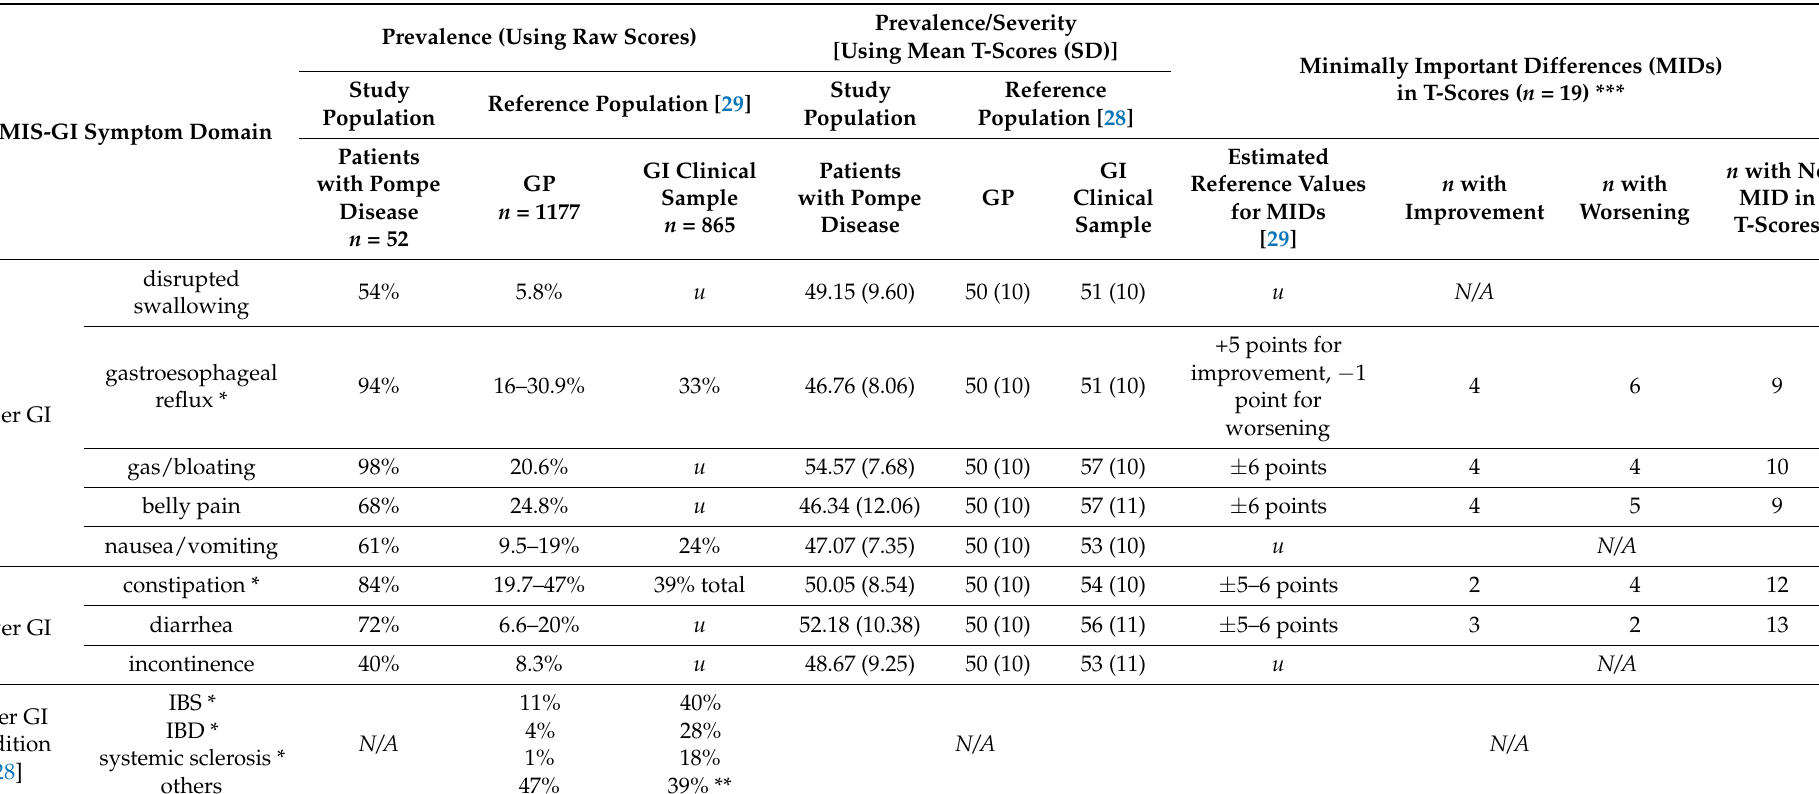
Table 2. GI problems in adult patients with late-onset Pompe disease using PROMIS-GI scales, when compared to the reference populations, and a measure of meaningful change in the T-scores of patients with Pompe disease on longitudinal